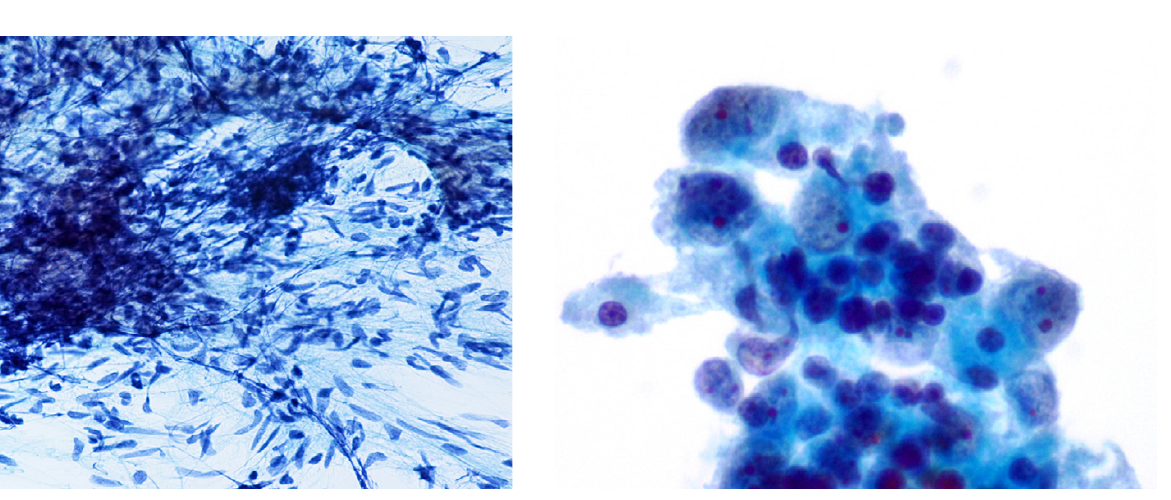
Figure 2 (Papanicolaou stain, × 600): Type AB thymoma. FNA smear shows neoplastic epithelial cells with dispersed chromatin and small nucleoli, and background